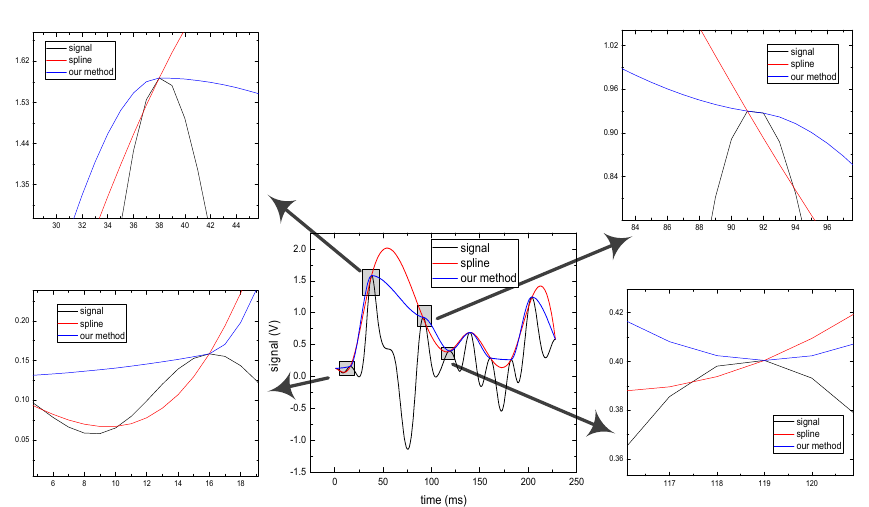
Figure 3. Envelope curve fitting of vibration signal.